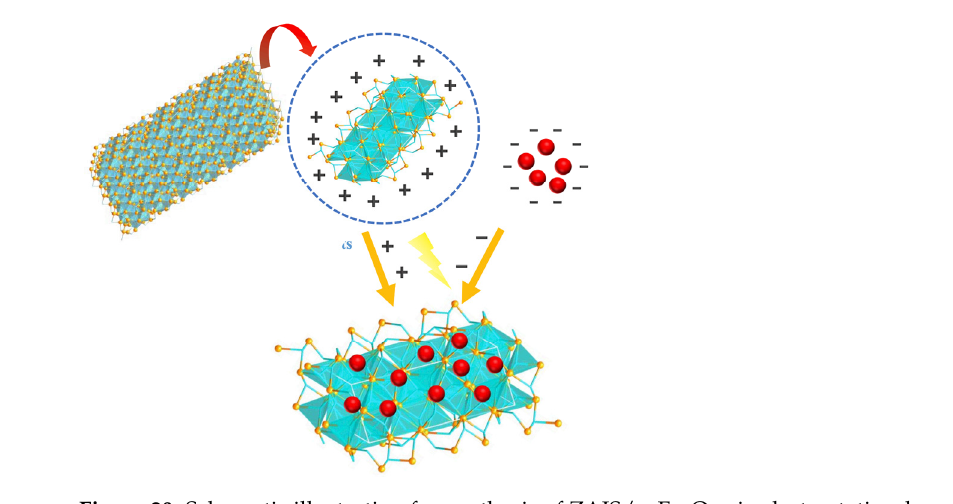
Figure 20. Schematic illustration for synthesis of ZAIS/ α -Fe 2 O 3 via electrostatic adsorption of the ZAIS QDs on α -Fe 2 O 3 nanosheets. Copyrights 2021 Elsevier [174].